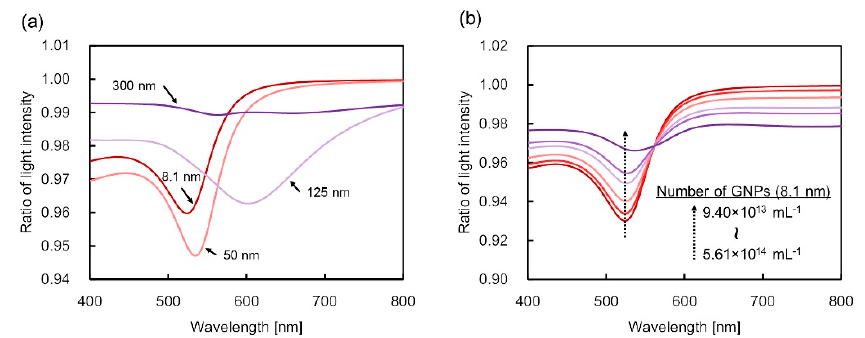
Figure 6. ( a ) Results of numerical calculations of optical extinction spectra accompanying the addition of L-cysteine at 2 wt% of the gold mass concentration. Values in the graph indicate particle diameters of GNPs. The dip value of the extinction spectrum shifts as the GNPs’ diameters in the dispersion solution increase homogeneously. Further, as the particle size increases to more than 125 nm, the number of particles interacting with the optical fiber propagation light decreases, so that the dip of the spectrum tends to decrease. ( b ) Results of numerical calculation by addition of L-cysteine at 4 wt% of mass concentration. The number of nanoparticles in the picoliter cuvette inside the optical fiber is predicted. The particle number of 8.1 nm GNPs decreases while that of the 200 nm GNPs increases. A 520 nm dip wavelength with a particle size of 8.1 nm is decreased. An increase in the 565 nm dip wavelength with a 200 nm particle size cannot be confirmed.